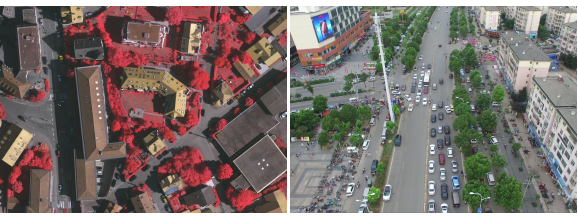
Figure 1. Example of images in different viewing style. The left image from Vaihingen dataset(Rottensteiner et al., 2014) is captured in nadir view. The right image from UAVid2020 dataset(Lyu et al., 2020) is captured in oblique